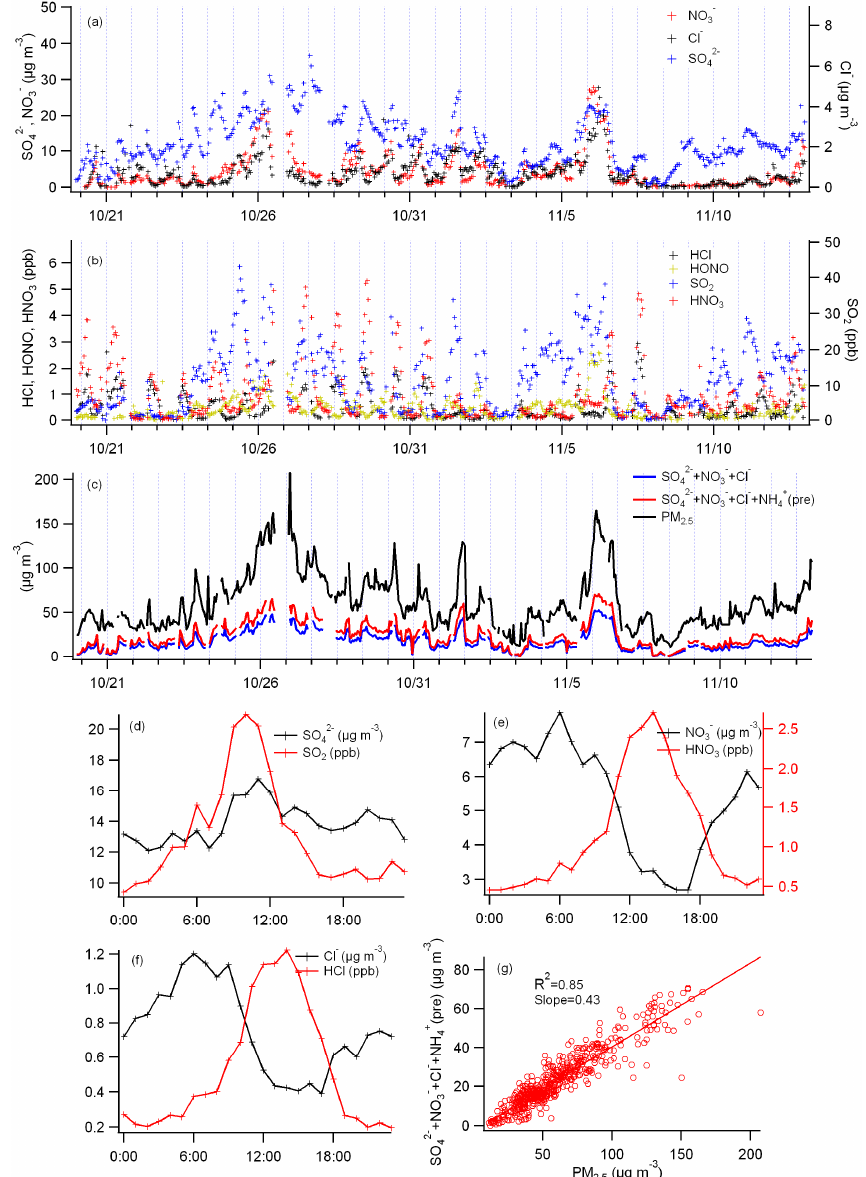
Fig. 9. The time series of (a) SO 2 − , NO − and Cl − ; (b) gaseous HCl, HONO, HNO 3 and SO 2 ; (c) SO 2 − + NO − + Cl − , SO 2 − + NO − + Cl − 4 3 4 3 4 3 + NH + (pre) and PM 2 . 5 ; the diurnal variation of (d) SO 2 − and SO 2 ; (e) NO − and gaseous HNO 3 ; (f) Cl − and gaseous HCl; the agreement Fig.9. The time series of (a) SO 42– , NO 3– and Cl – ; (b) gaseous HCl, HONO, HNO 3 and 4 4 3 between (g) SO 2 − + NO − + Cl − + NH + (pre) and PM 2 . 5 . 4 3 4 SO 2 ; (c) SO 42– + NO 3– + Cl – , SO 42– + NO 3– + Cl – + NH 4+ (pre) and PM 2.5 ; The diurnal variation of (d) SO 42– and SO 2 ; (e) NO 3– and gaseous HNO 3 ; (f) Cl – and gaseous HCl; Table 2. The statistics of major species measured by the GAC-IC system and PM 2 . 5 by the TEOM (hourly The agreement between (g) SO 42– + NO 3– + Cl – + NH 4+ (pre) and PM 2.5 .